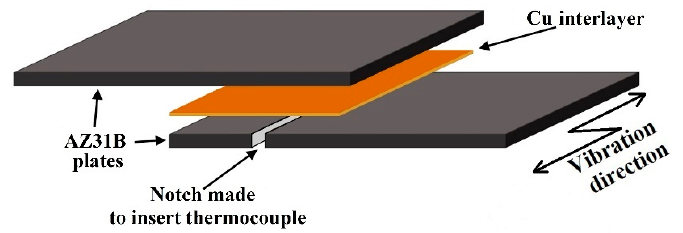
Figure 3. Schematic configuration for temperature measurement.